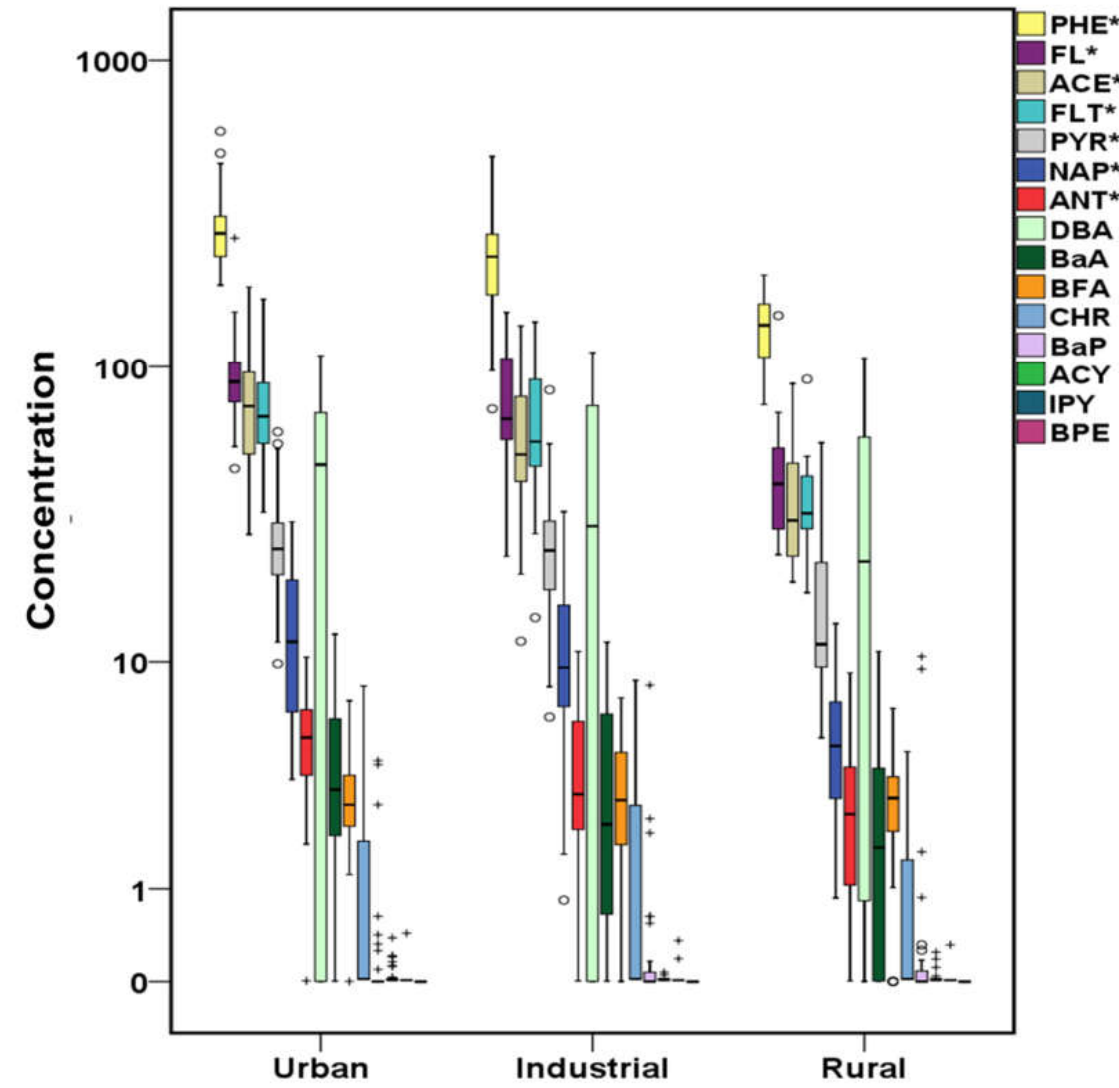
Figure 9. PAHs variation according to the area of residence of cases in µ g L − 1 ( + outliers and o values above 3rd quartile and * p -value <0.05) in logarithmic scale (PHE:phenanthrene, FL:fluorene, ACE:acenaphthene, FLT:fluoranthene, PYR:py-